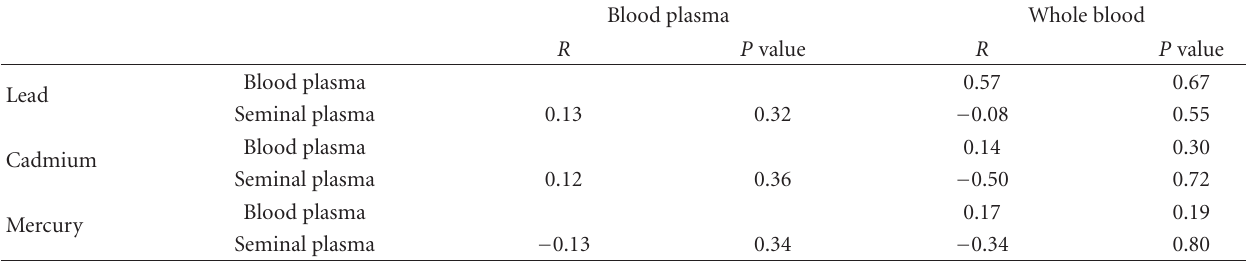
Table 4: Spearman’s correlation coe ffi cients between metal concentrations in seminal and blood plasma, and whole blood.